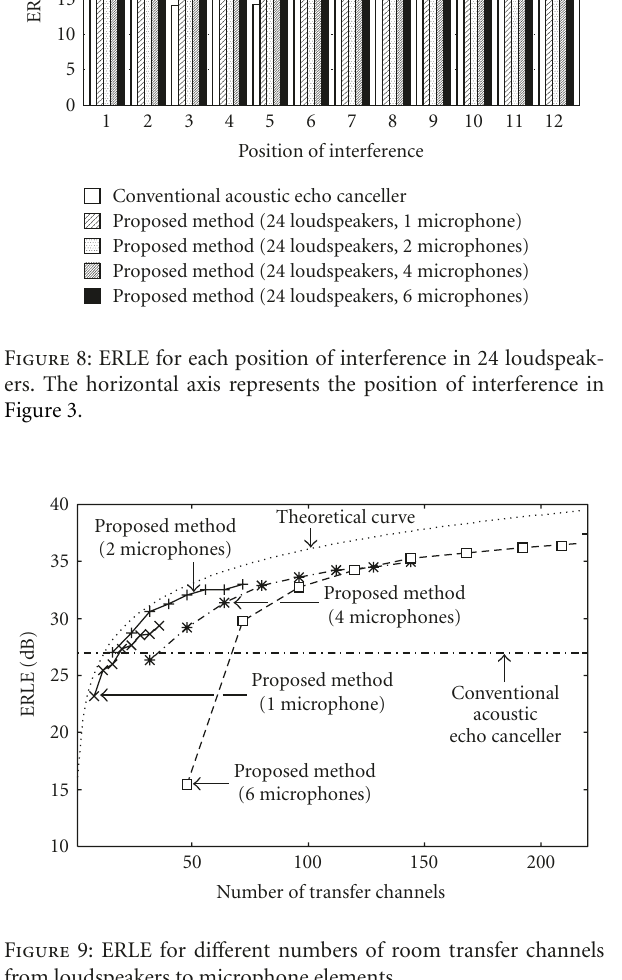
Figure 9: ERLE for di ff erent numbers of room transfer channels from loudspeakers to microphone elements.